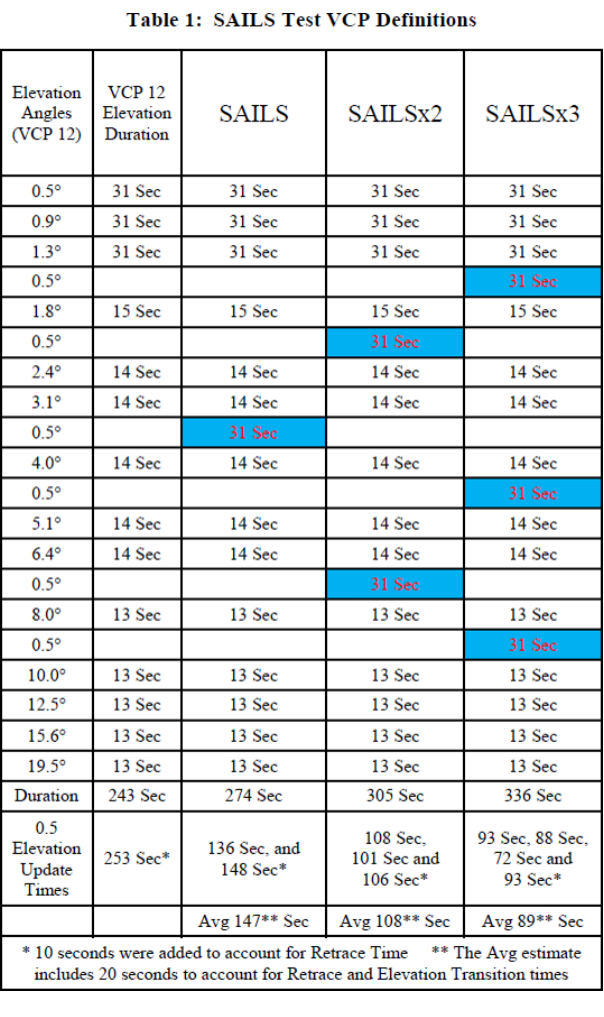
Figure A1. WSR-88D MESO-SAILS scanning regiment with average times for measurement sweeps; from NOAA